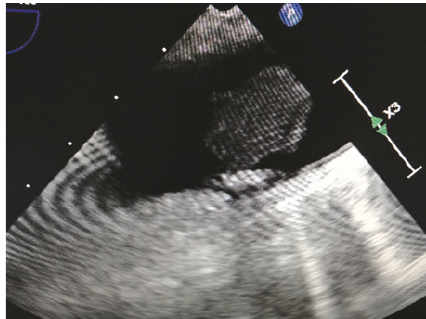
Figure 3: | Transesophageal echocardiography showed a 23mm mobile thrombus in the lesser curvature of aortic arch.